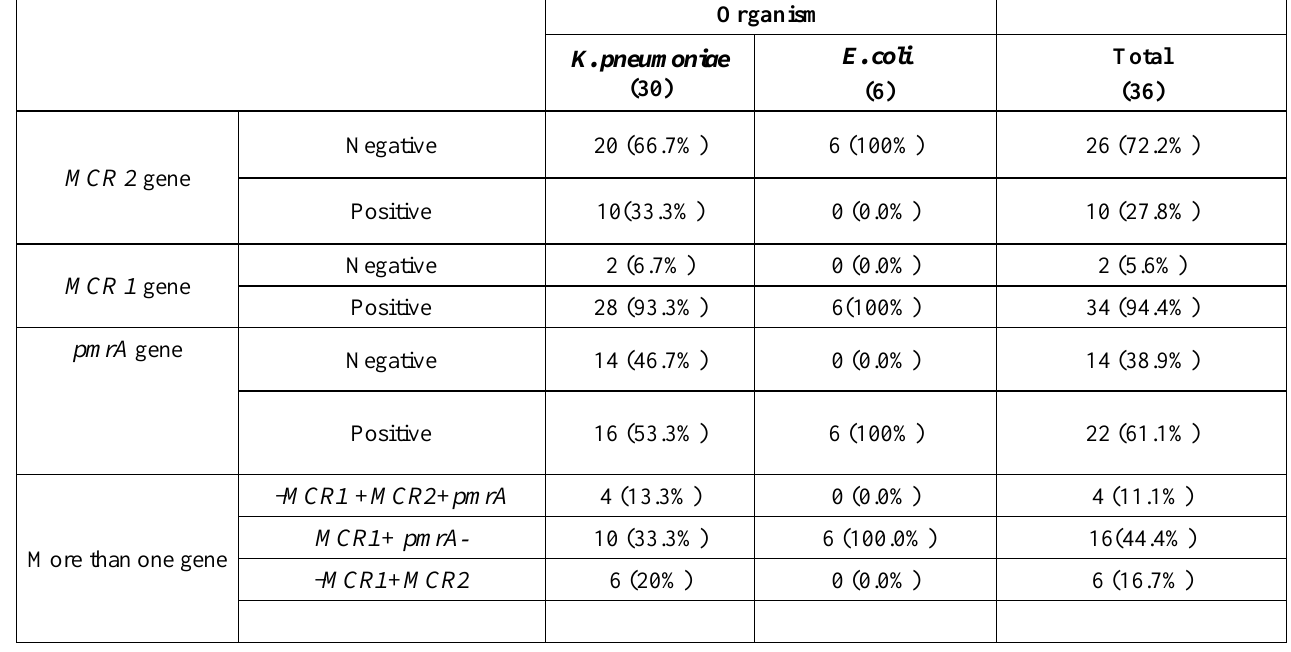
Table 6. Colistin resistance genes among colistin resistant K. pneumoniae and E. coli